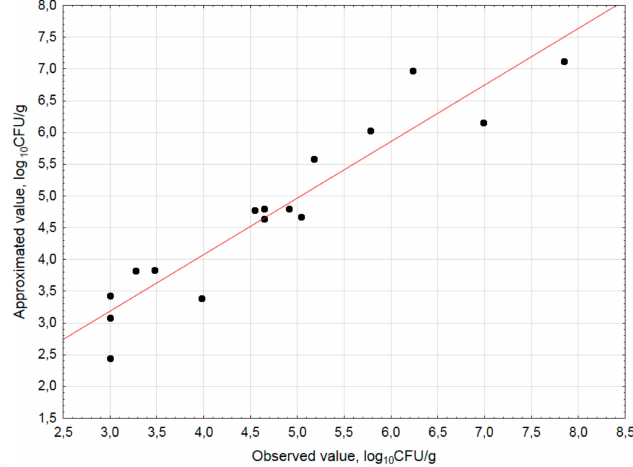
Figure 3. The correlation between the estimated and observed values ( E. coli , log 10 CFU/g, 3 value, 1 block, 16 experiments, MS = 0.3877).